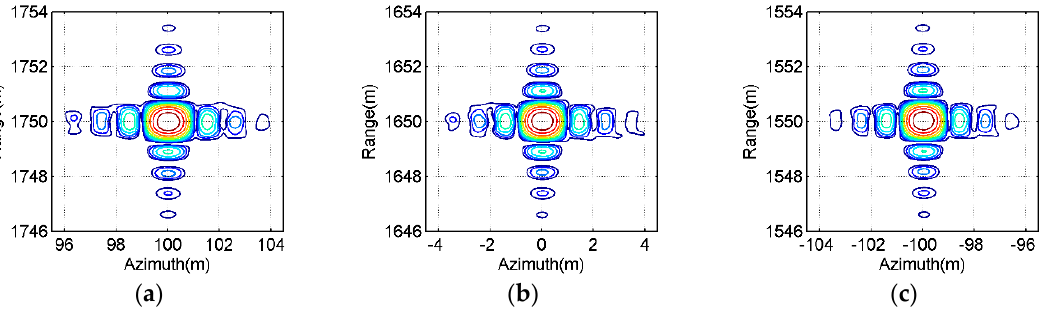
Figure 10. Contours of imaging results obtained by the proposed ETDA for all selected point-like scatterers in Figure 8a. ( a ) Scatterer C; ( b ) Scatterer E; ( c ) Scatterer G.